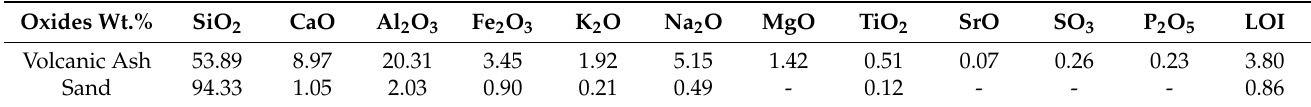
Table 1. Chemical composition for sand and volcanic ash.